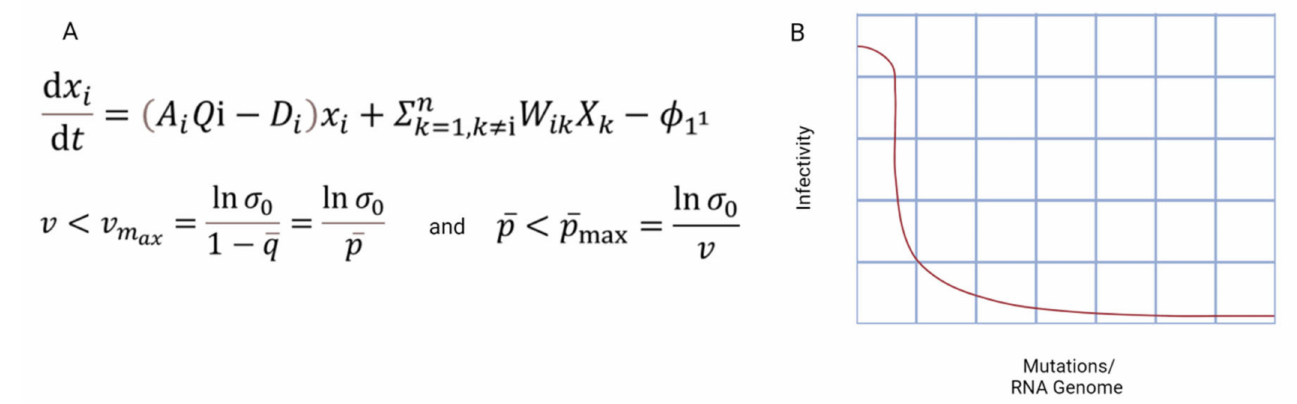
Figure 1. Quasispecies theory is described by using two fundamental equations. ( A ) The first equation describes the change in the concentration of mutant i with respect to time, xi(t); similarly, xk(t) describes the concentration of mutant k. The second equation expresses the error threshold relationship. The second equation has importance in virology and lethal mutagenesis, where the mutation rate pushes the virus beyond the error threshold and has benefits in drug development. ( B ) Error Threshold: the higher the mutations, the lower the